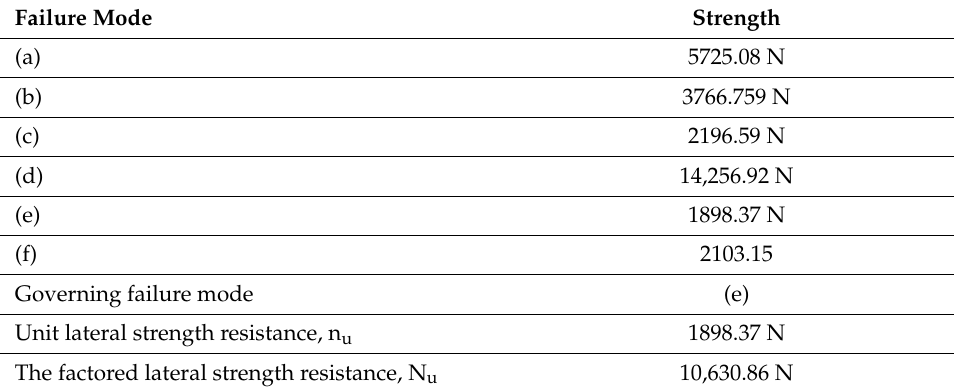
Table A2. Strength in different failure